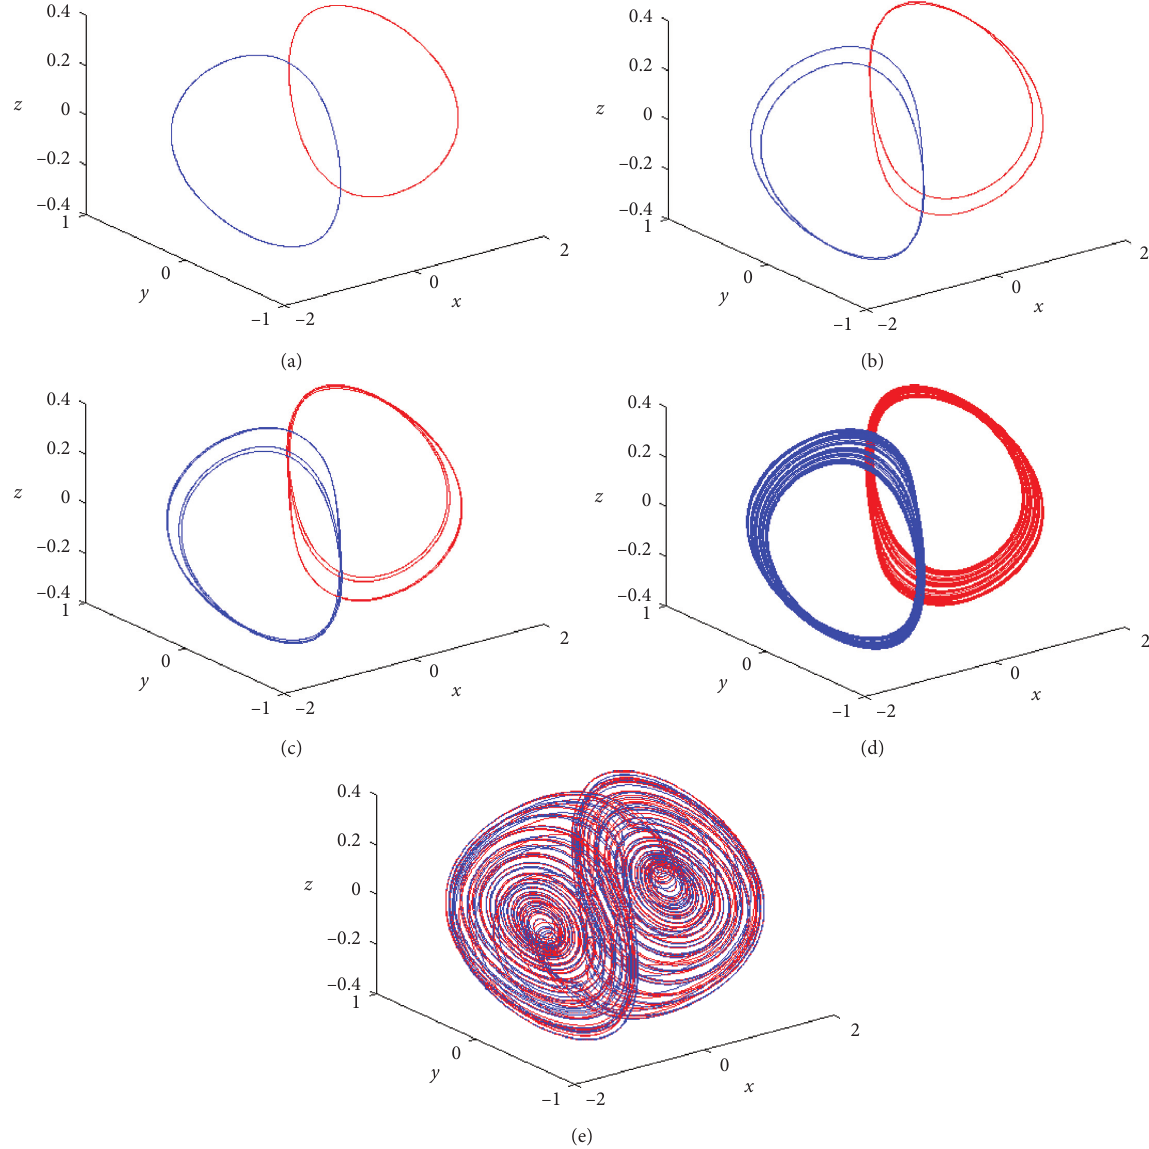
Figure 3: Three-dimensional representations ( x − y − z ) of trajectories in phase space, at different points of the bifurcation diagram of the symmetry system (Figure 1(a)) for different values of b : (a) cycle of period-1 for b � 0 . 22, (b) cycle of period-2 for b � 0 . 28, (c) cycle of period-4 for b � 0 . 284, and (d, e) single and double chaotic bands for b � 0 . 288 and b � 0 . 3, respectively. The initial conditions are ( x ( 0 ) , y ( 0 ) ,z ( 0 )) � ( 0 . 25 , 0 , 0 ) and (− 0 . 25 , 0 , 0 ) for the curves in red and blue,